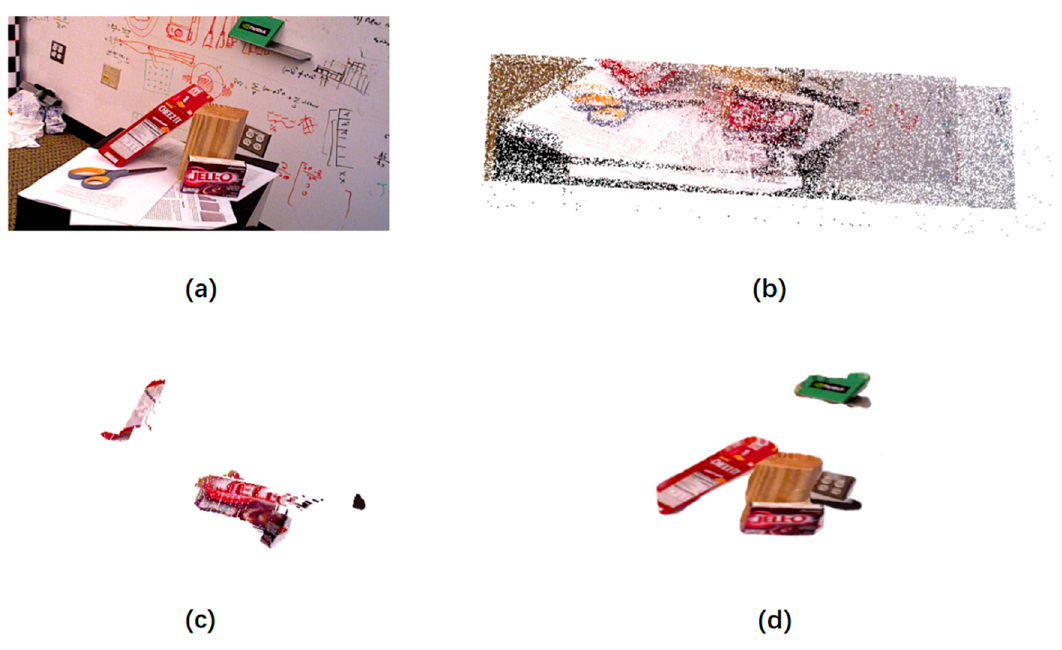
Table 5. The performance of our method and other main methods on the YCB-Video dataset.